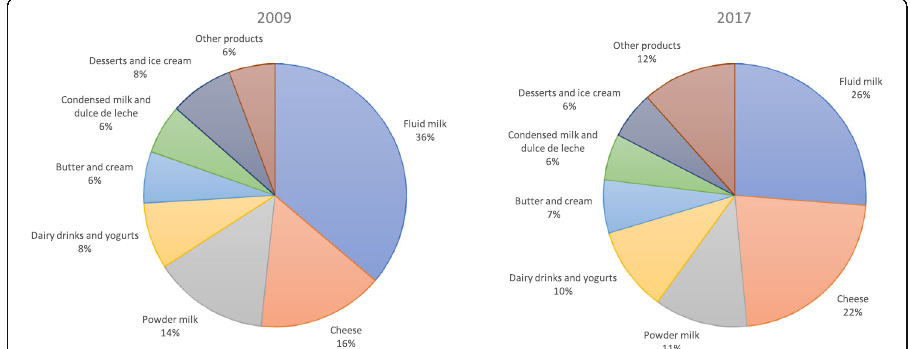
Fig. 1 Share of products in the total GVIP of dairy processing companies in 2009 and 2017. Source: IBGE - Industrial